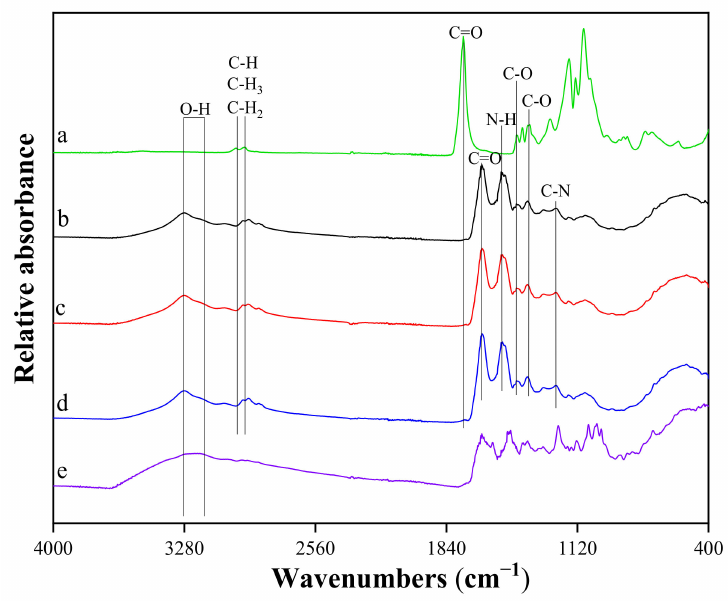
Figure 8. FTIR spectra of: ( a ) PLGA_ µ C _Blank; ( b ) PRF scaffold; ( c ) PRF/ PLGA_ µ C _Blank scaffold; ( d ) PRF/ PLGA_ µ C_VANKA scaffold; ( e )